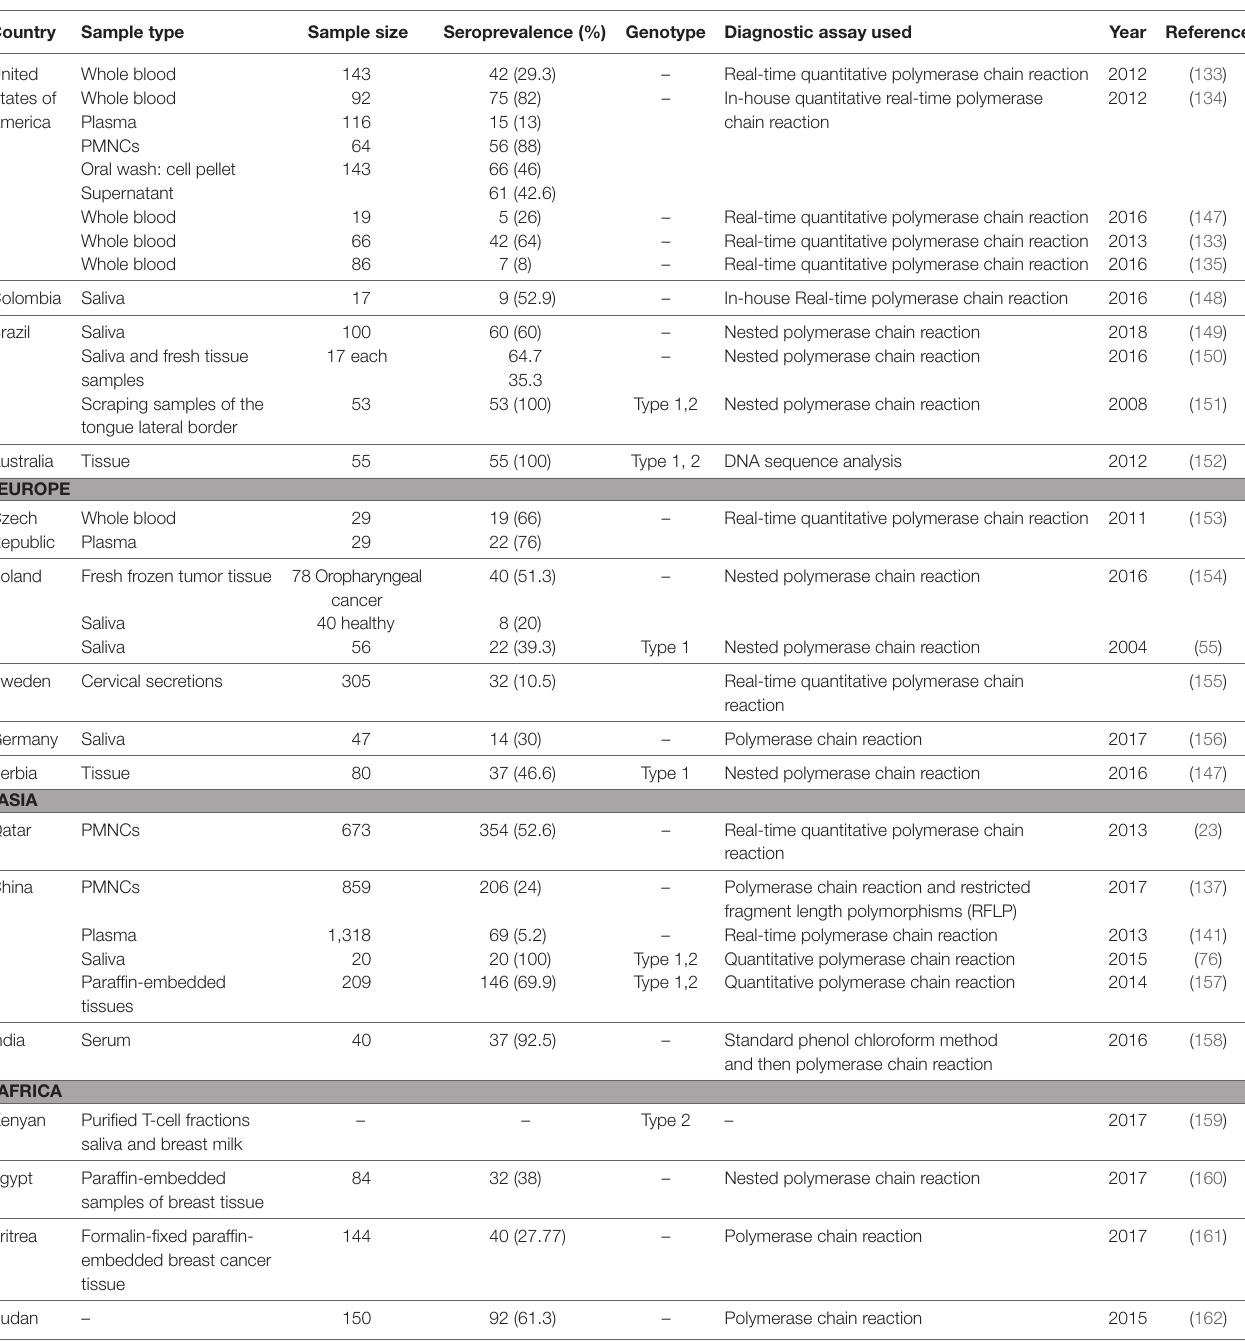
TABLe 2 | Prevalence of Epstein–Barr virus DNA in various samples.